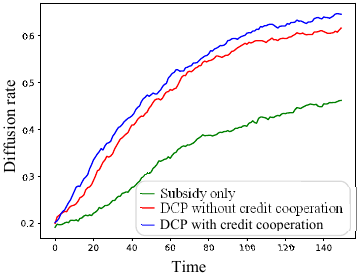
Figure 5. Results in small world network.